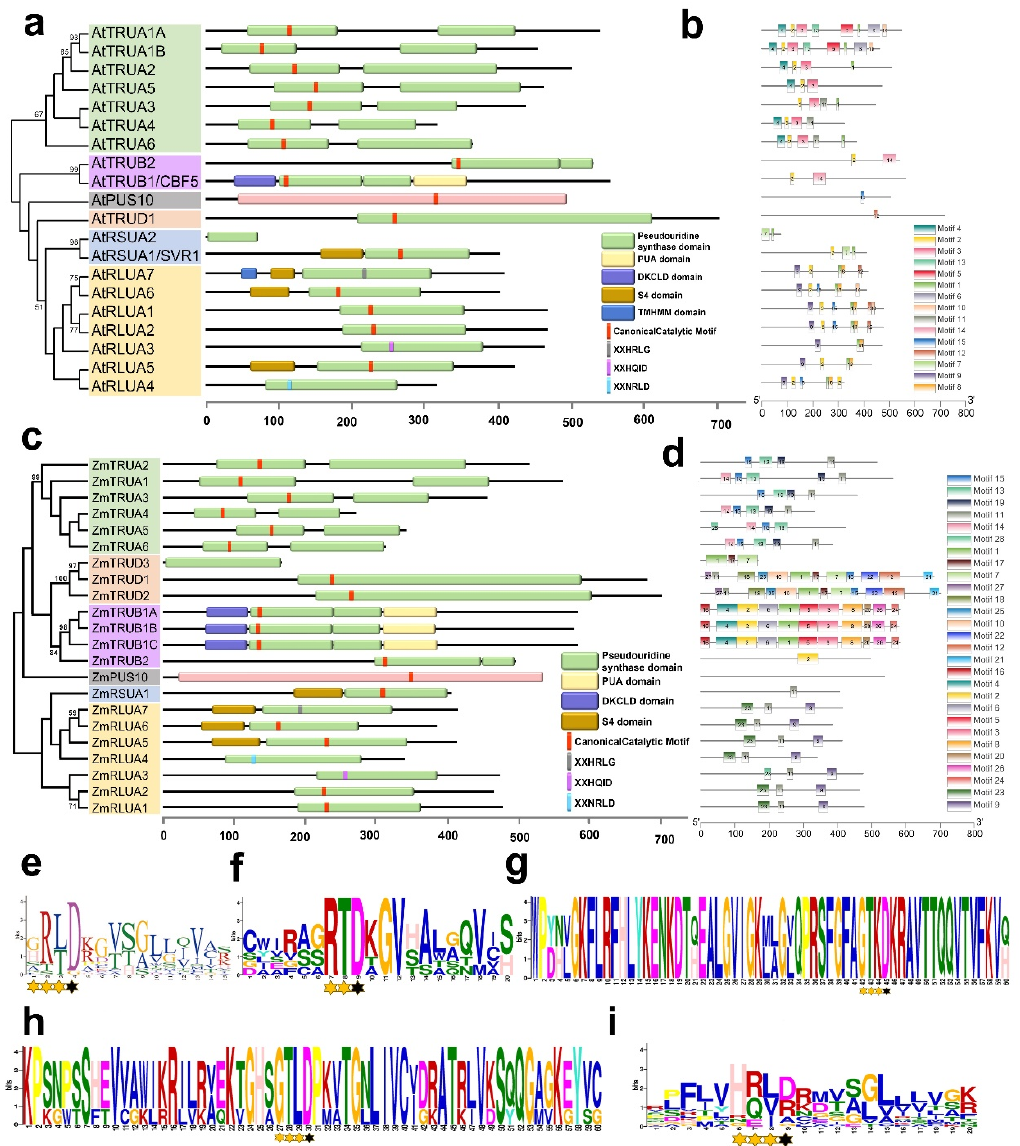
Figure 4. Conserved domains and motifs of AtPUS and ZmPUS proteins. ( a ) Conserved domains of AtPUS proteins. ( b ) Conserved motifs of AtPUS proteins. ( c ) Conserved domains of ZmPUS proteins. ( d ) Conserved motifs of ZmPUS proteins. ( e ) Frequency distribution of amino acids in the motif 2 of AtPUS proteins. ( f ) Frequency distribution of amino acids in the motif 15 of ZmPUS proteins from TruA subfamily. ( g ) Frequency distribution of amino acids in the motif 10 of ZmPUS proteins from TruD subfamily. ( h ) Frequency distribution of amino acids in the motif 2 of ZmPUS proteins from TruB subfamily. ( i ) Frequency distribution of amino acids in the motif 11 of ZmPUS proteins from RluA and RsuA subfamilies. The conserved active Asp was indicated by closed asterisk; the other conserved amino acids were indicated by open asterisk.